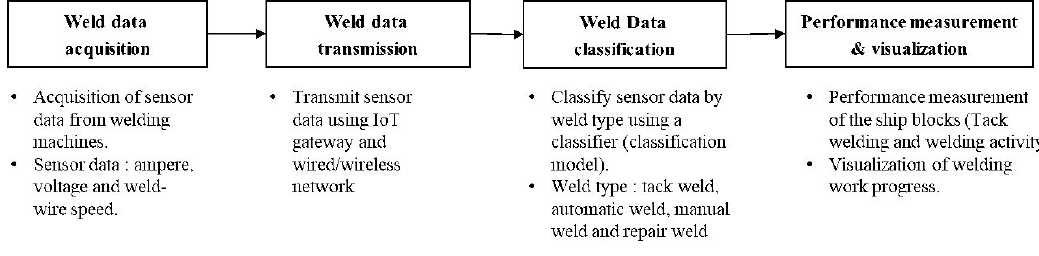
Figure 11. Procedure for measuring the progress of welding